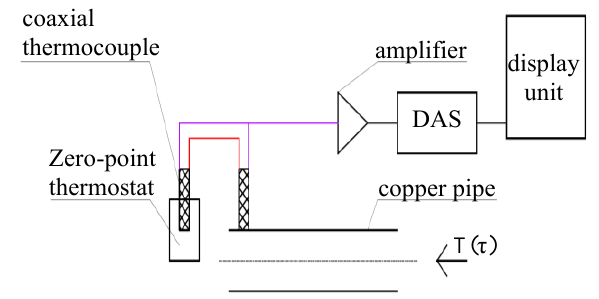
Fig. 2. Temperature measuring